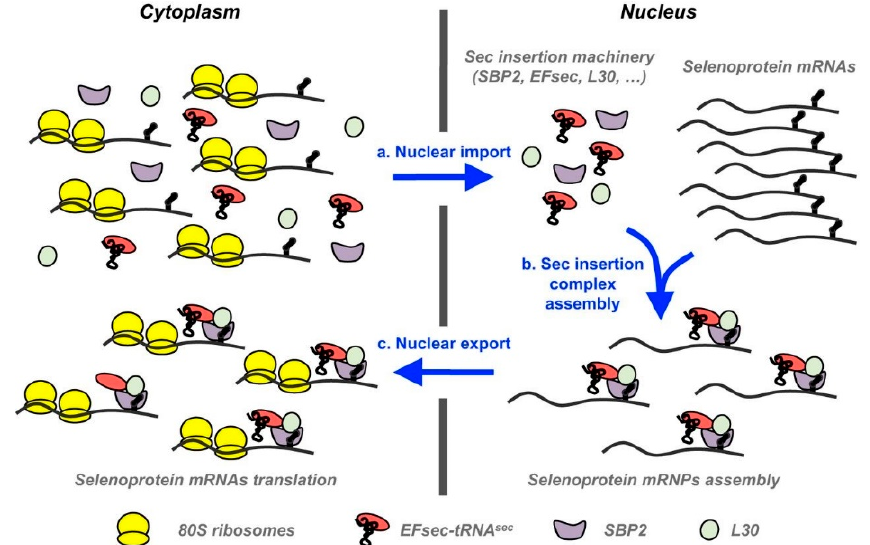
Figure 2. Schematic of the nuclear selenoprotein mRNPs assembly. “Recoding factors are imported into the nucleus to assemble with selenoprotein mRNAs. mRNPs are built and exported to the cytoplasm to promote efficient translation by the ribosome. An increase in nucleocytoplasmic shuttling in response to H 2 O 2 induced oxidative stress is proposed to improve selenocysteine insertion complex nuclear assembly and, consequently, selenoprotein expression”. Credit